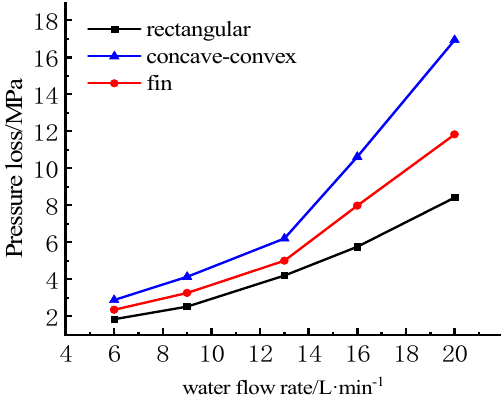
Figure 14. Relations between water flow rate and pressure loss.